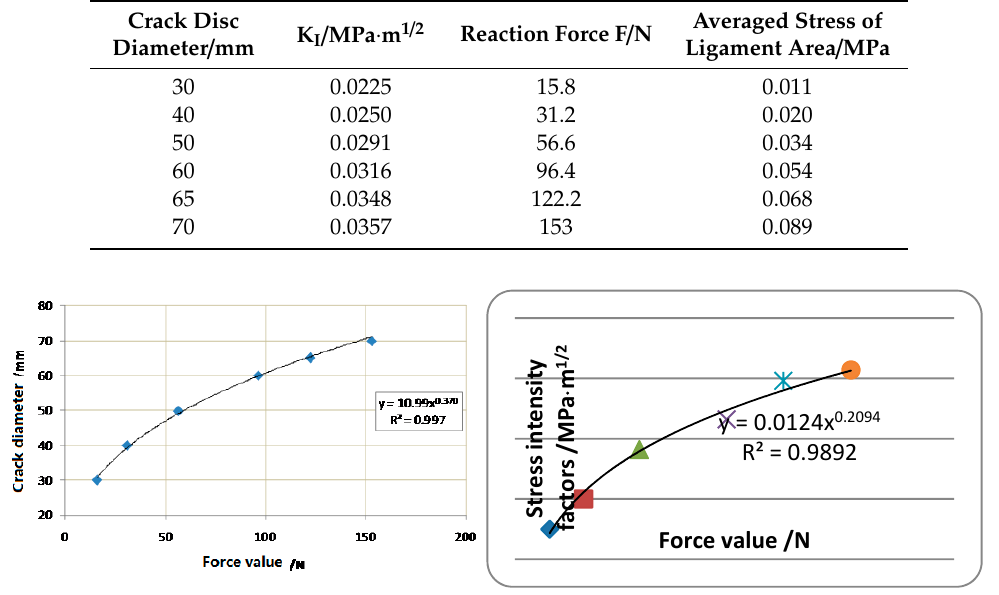
Figure 19. Relationships between crack disc diameter, stress intensity factor (SIF), and reaction force.